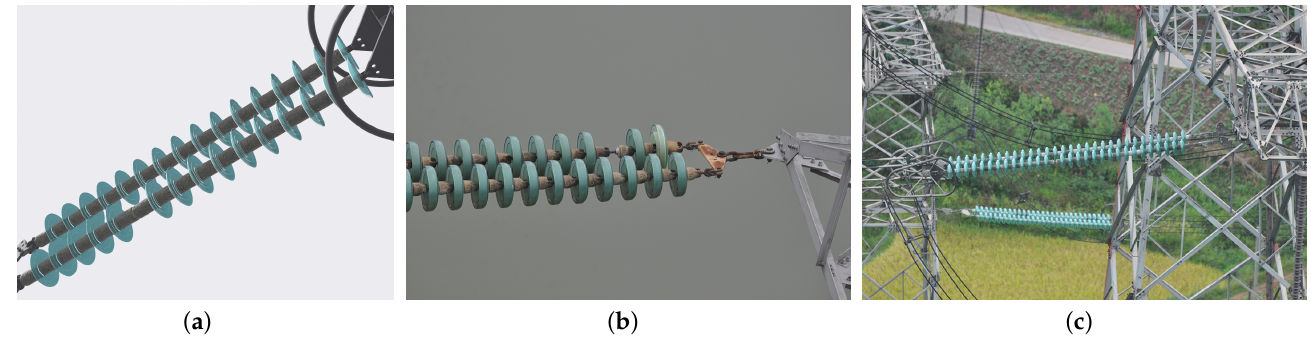
Figure 1. ( a ) 3D display of defect insulator with umbrella skirt missed. ( b ) Real defect insulator with a uniform background. ( c ) Real defect insulator with a complex